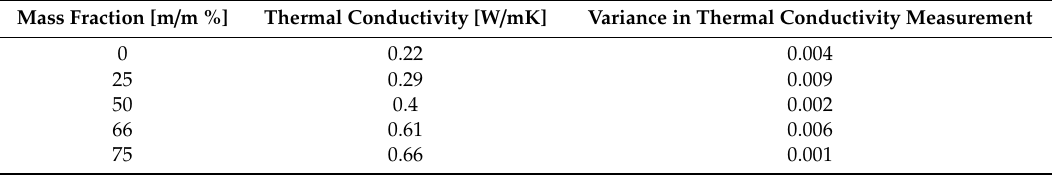
Figure 10. One of our custom-made phosphor samples on the measurement stage of a Mentor DynTIM (dynamic thermal interface material thermal conductivity measurement) equipment [45]. Table 1. Measured thermal conductivity of phosphor layer with different phosphor powder concentration.